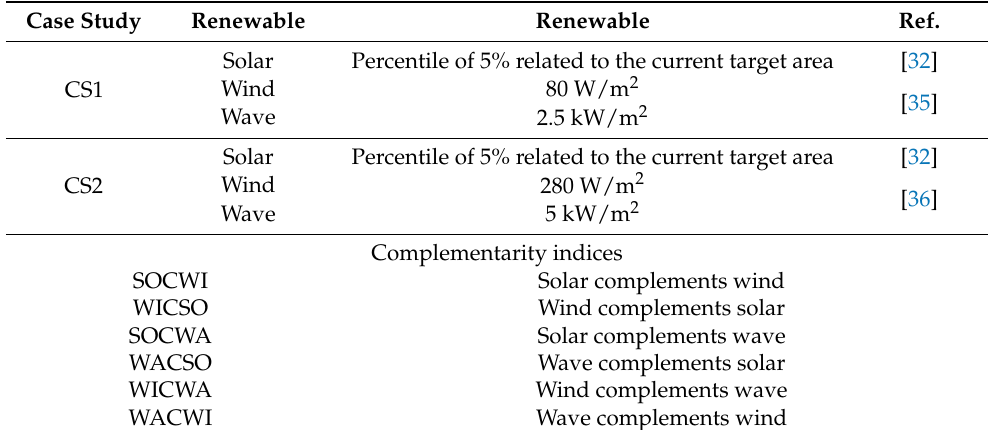
Table 1. The case studies considered for the complementarity assessment of the solar-wind-wave resources. Case